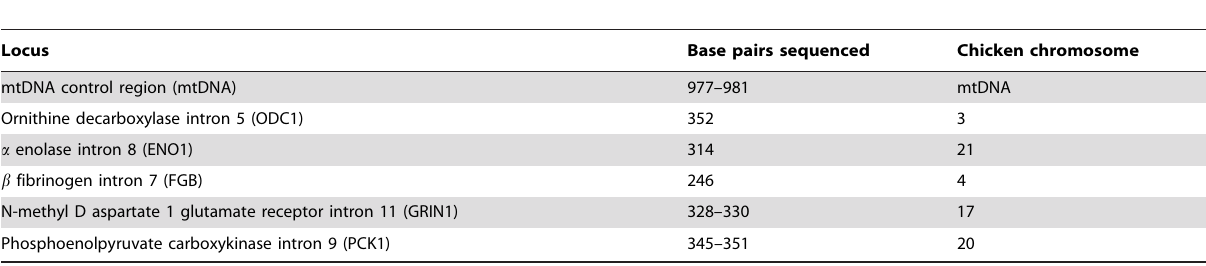
Table 1. Genes sequenced and their chromosomal positions in the chicken genome.